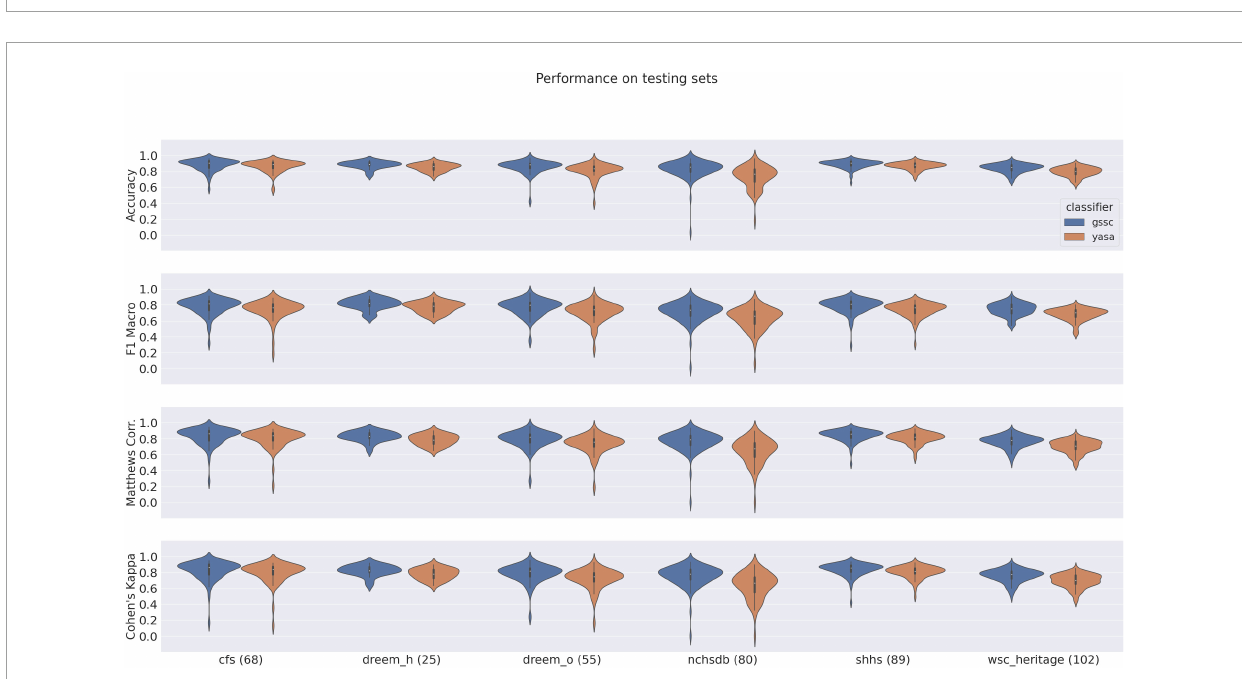
FIGURE6 Violin plots of performance over all testing datasets for YASA and the Greifswald Sleep Stage Classifier (GSSC). Measures shown here include Accuracy, F1 Macro, Matthews Correlation Coeffecient and Cohen’s Kappa. Numbers in parentheses by the dataset name indicate the number of PSGs within that testing